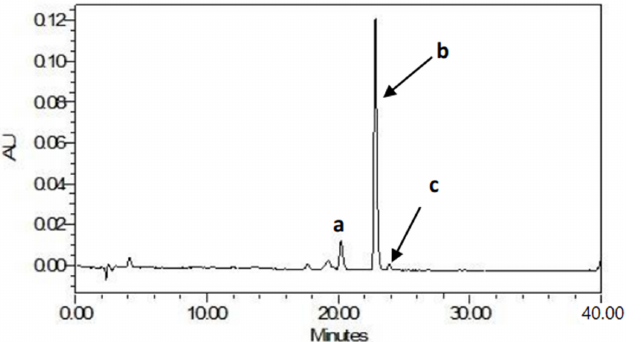
Figure 1. HPLC chromatogram showing beta-carotene peaks in the extract of orange-fleshed sweet potato composite bread at 450 nm. Peak identification: (a) 13-cis ß-carotene, (b) all-trans ß-carotene (c) 9-cis ß-carotene.